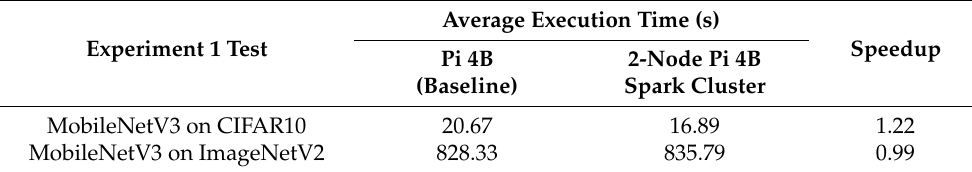
Table 8. Comparison of average execution time and speedup between a single Pi 4B and a 2-node Pi 4B cluster for Experiment 1.